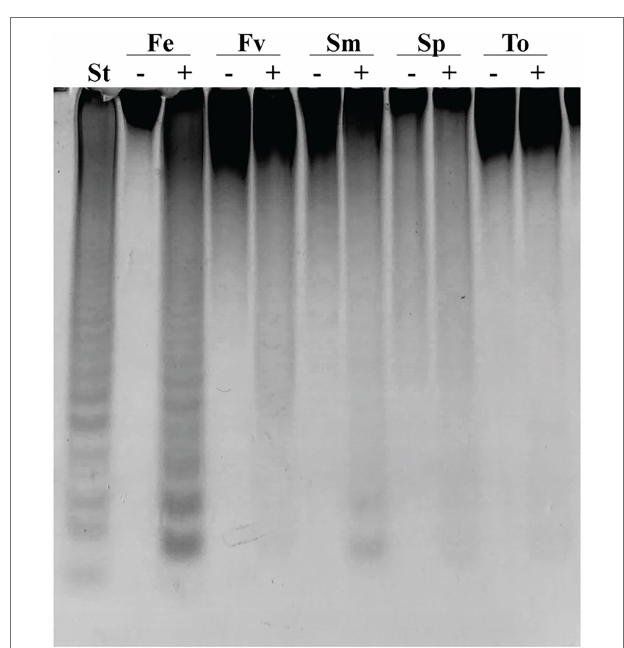
FIGURE 4 | C-PAGE of Fhf2 ∆ 484 activity on fucoidans from different brown seaweed species. ( − ) indicates control substrate and (+) Fhf2 ∆ 484 enzymatic reactions on fucoidans from different seaweed species F. evanescens (Fe), F. vesiculosus (Fv) , S. mcclurei (Sm), S. polycystum (Sp) and T. ornata (To). (St) positive control reaction of FFA2 on F. evanescens fucoidan. Reaction conditions were 0.9% substrate, 0.3 mg/ml enzyme, 10 mM Tris-HCl pH 7.4 and 125 mM NaCl at 35 ° C for 24